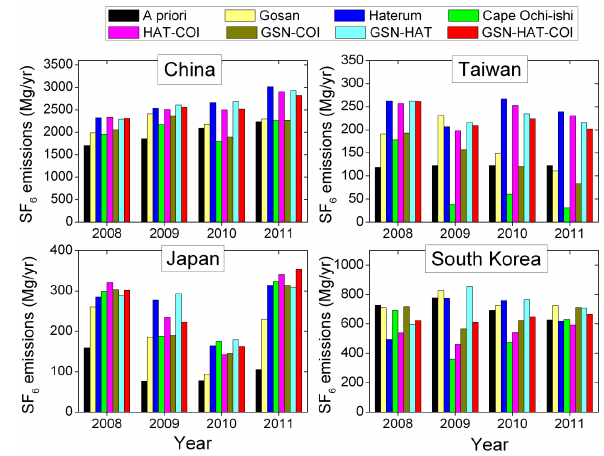
Fig. 3. A priori and a posteriori national SF 6 emissions in East Asia for the years 2008–2011. A posteriori results are from the reference inversion but using measurement data from only one, two or all three East Asian measurement stations (GSN = Gosan, HAT = Hateruma and COI = Cape Ochi-ishi).